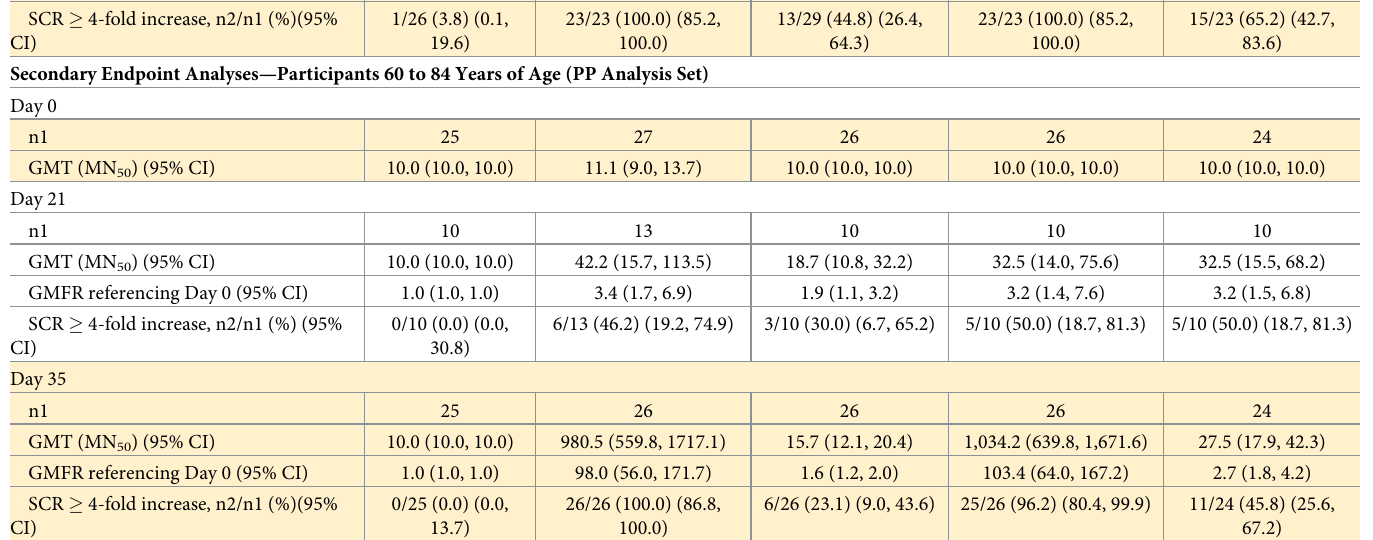
was 100% for younger participants (Table 2). For older participants, neutralizing antibody GMTs (MN ) at Day 35 were 981, the GMFR was 98, and the seroconversion rate was 100% 50 (Table 3). Neutralizing antibody responses of the 2-dose regimens of 5- μ g (Group B) and 25- μ g (Group D) NVX-CoV2373 in both younger and older participants exceeded those seen in a panel of convalescent sera (Fig 3).